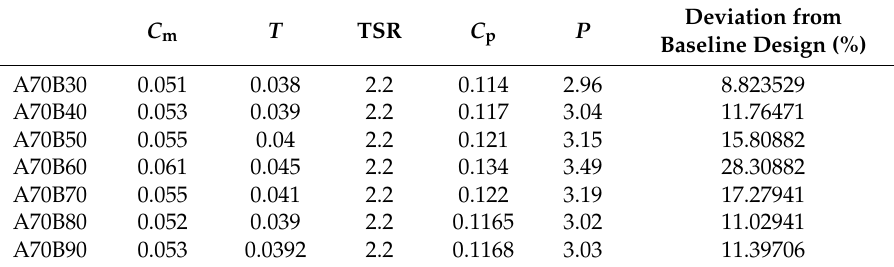
Table 4. The results and other specifications of the various cases.